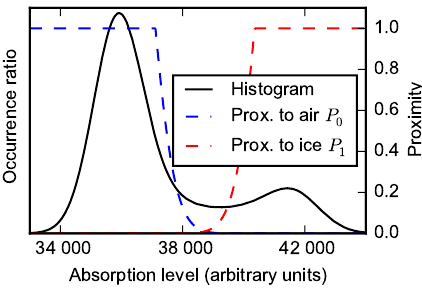
Figure 5. Proximity functions to air ( P 0 ) and to ice ( P 1 ) computed from Eqs. (4) and (5), and the three Gaussians histogram fit obtained on image